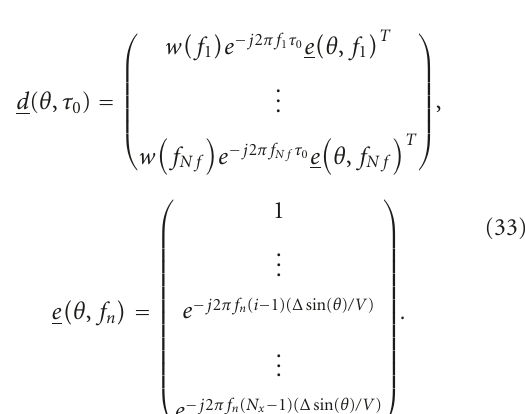
Figure 8: Modulus of the multicomponent wideband spectral matrix of the first extracted wave, Γ with